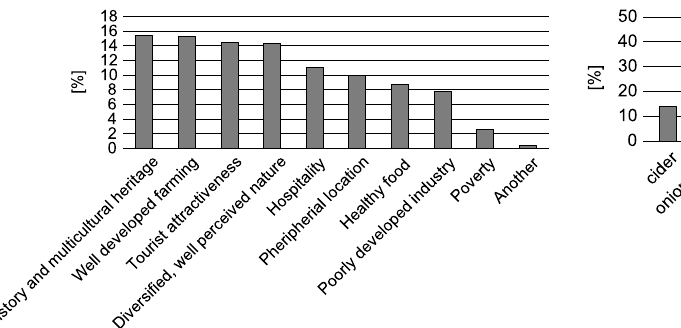
Fig. 5. Products and regional dishes which respondents associated with lubelskie voivodeship.